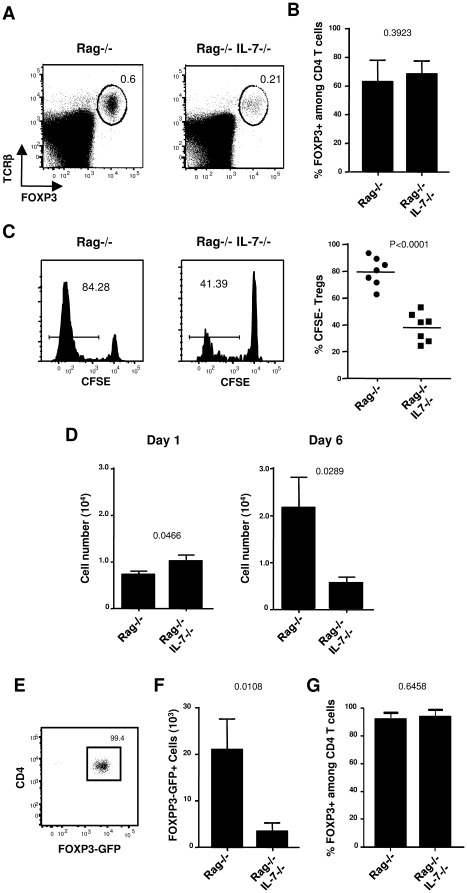
IL-7 promoted expansion of FOXP3+ Treg cells in lymphopenic hosts.(A, B, C) 1.106 CFSE labeled, purified CD4+CD25+ T cells were transferred into Rag−/− and Rag−/− IL-7−/− mice. (A) Representative dot plots of FOXP3 vs TCRβ expression on splenic lymphocytes at day 6 after transfer. (B) Percentages of FOXP3+ cells among CD4+ TCRβ+ cells at day 6 after transfer. (C) Representative profiles of CFSE dilution of CD4+ TCRβ+ FOXP3+ cells at day 6 after transfer, and graph of CFSElow Tregs percentage recovered from three experiments using two to three mice per group. (D) Total splenic numbers of CD4+TCRβ+FOXP3+ cells recovered per mouse at day 1 and 6. (E,F,G) 5 105 CD4+ GFP+ cells isolated from Foxp3GFP mice were transferred into Rag−/− and Rag−/−IL-7−/− mice. (E) Representative dot plots of FOXP3GFP vs CD4 expression in FACS sorted Treg cells before transfer. (F) Total splenic numbers of CD4+TCRβ+FOXP3GFP+ cells recovered per mouse at day 8. (G) Percentages of FOXP3GFP+ cells among CD4+TCRβ+ cells at day 8 after transfer. Experiments were repeated twice with three mice per group. Data shown are representative of one experiment.